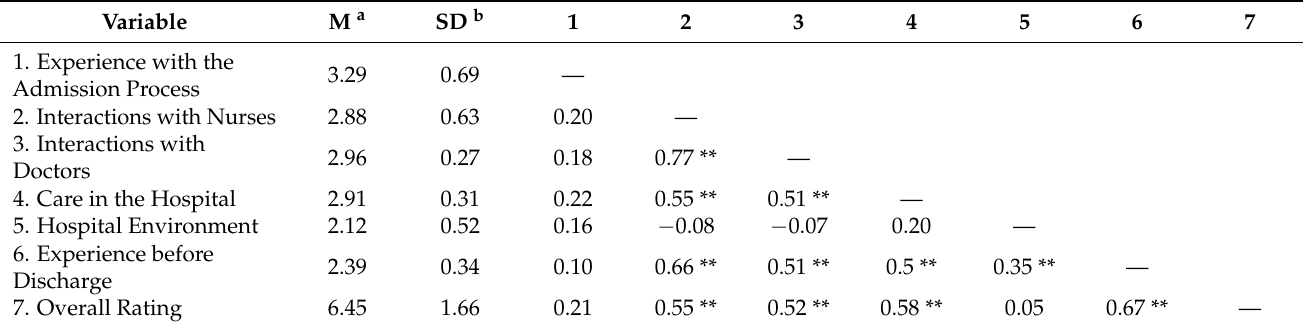
Table 3. Pearson correlations for parent domain